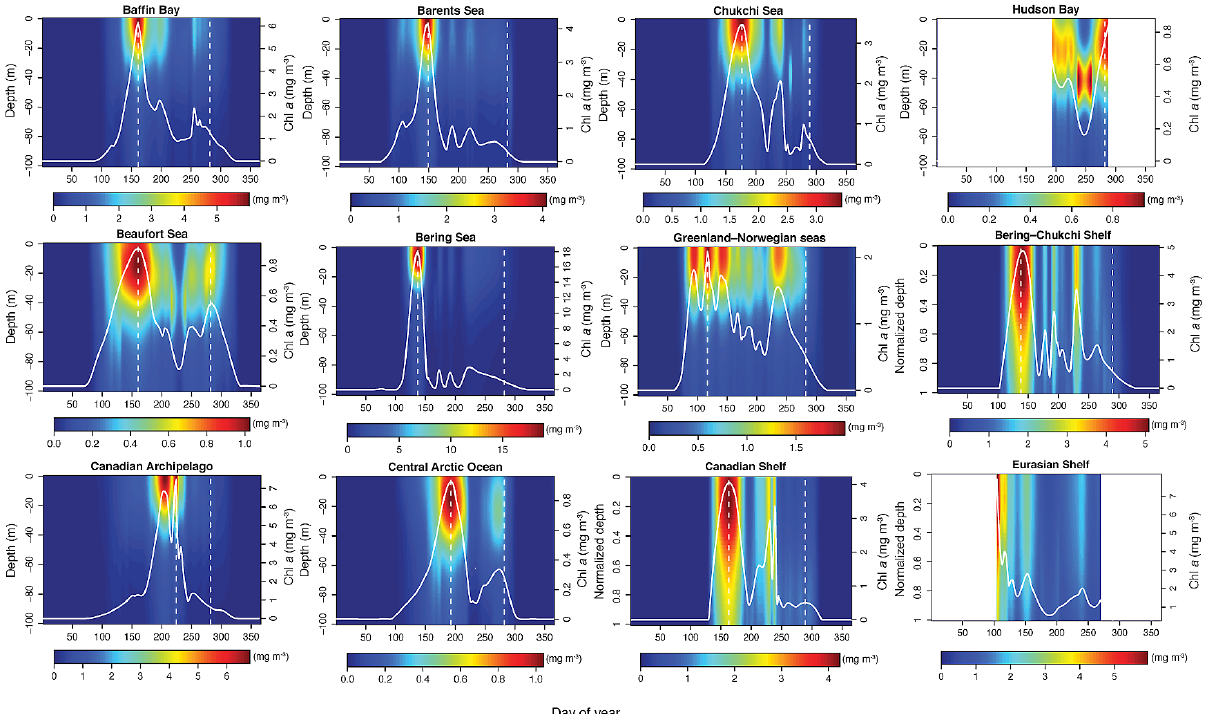
Fig. 9. Annual time series of surface chlorophyll a (Chl a surf ) concentration combined to simulated vertical distribution of Chl a using the empirical model for each sub-Arctic and Arctic sea. The two vertical dashed lines represent the two temporal delimitations, separating the pre-bloom, post-bloom, and the winter period (see Fig.